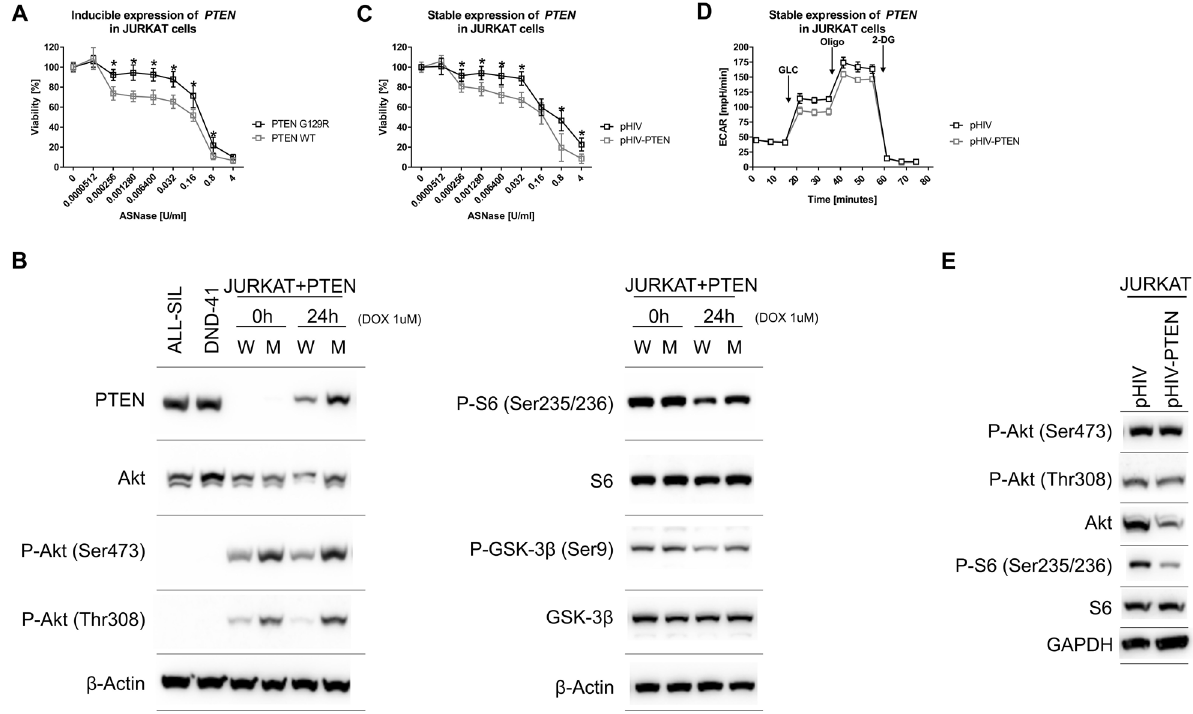
Figure 4. PTEN overexpression in JURKAT cells. ( A ) The effect of inducible PTEN WT and PTEN G129R expression on the sensitivity of JURKAT cells to ASNase based on MTS assays. ( B ) The immunoblot analysis of PTEN, P-Akt (Ser473), P-Akt (Thr308), P-S6, S6, P-GSK-3β and GSK-3β in JURKAT cells with inducible PTEN WT (W) and PTEN G129R (M) expression, ALL-SIL and DND-41 cell lines. β-Actin is shown as a loading control. ( C ) The sensitivity of JURKAT cells transduced with pHIV-PTEN or EV to ASNase based on MTS assays. ( D ) The glycolytic profile of JURKAT cells transduced with pHIV-PTEN or EV was determined using Seahorse XFp analyzer and Glycolysis Stress Test. ( E ) The immunoblot analysis of P-Akt (Ser473), P-Akt (Thr308), P-S6 and S6 in JURKAT cells transduced with pHIV-PTEN and EV. GAPDH is shown as a loading control. The MTS assays were done at least in biological triplicates and six technical replicates. * = FDR < 0.1%. The Seahorse measurements were done at least in biological triplicates and six technical replicates. All the results are presented as a mean ± SD. Each immunoblot is a representative result of three independent experiments. Different gels are separated by vector = pHIV-EGFP, Fig. 4E). Further corroborate, the pHIV-PTEN vector expresses eGFP from the PTEN- IRES-eGFP cassette, therefore all GFP-positive cells should also express PTEN. Akt inhibition increases sensitivity to ASNase in some primary T‑ALL cells. The results from the T-ALL cell lines indicated a possible therapy target for T-ALL patients with a PTEN deletion/mutation. There-